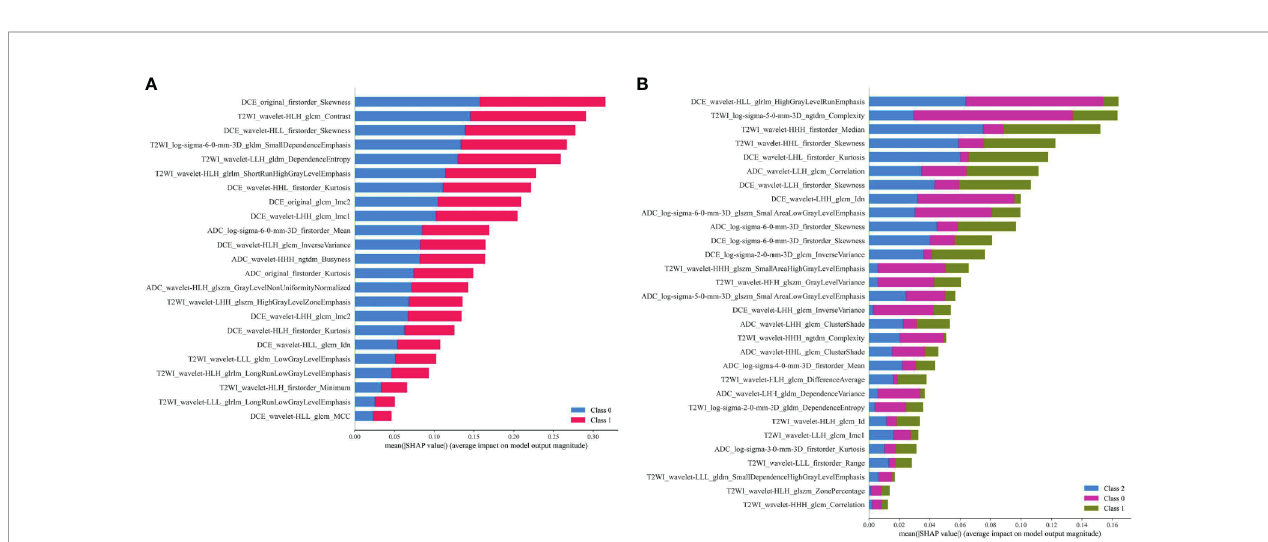
FIGURE 8 | (A) Feature contribution weights for the MLP model predicting AR expression, and class 0 means AR < 10%, class 1 means AR ≥ 10%; (B) Feature contribution weights for the MLP model predicting molecular subtype, and class 0 means TNBC, class 1 means HER2+, class 2 means HR+/HER2 − .